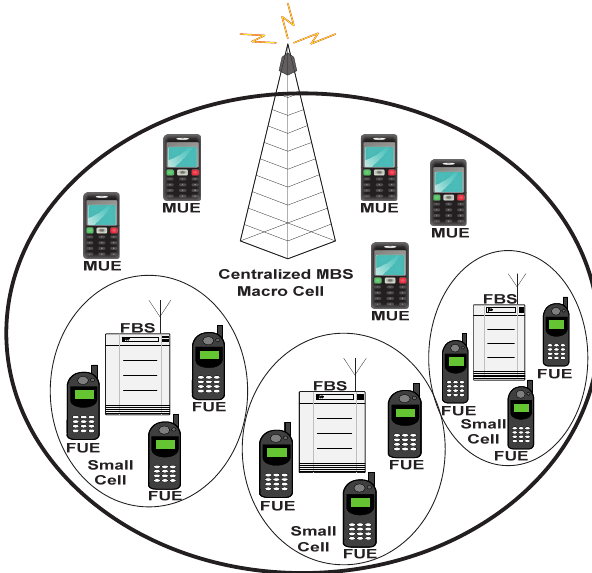
Fig. 3. System Model for 5G heterogeneous cellular